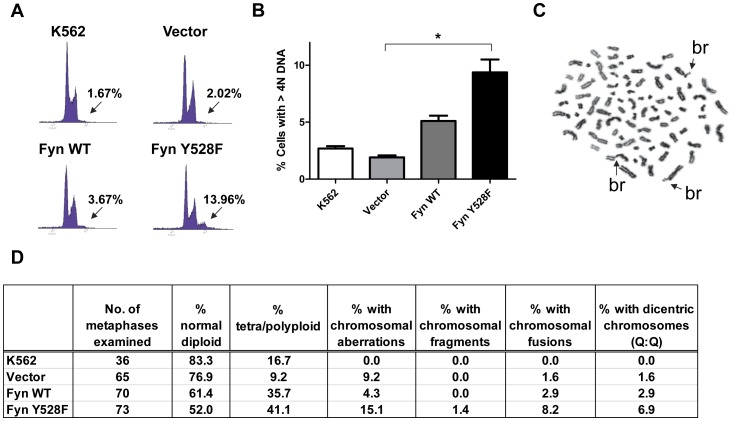
Increased Fyn kinase activity leads to the accumulation of genomic instability in CML cells.(A) Cell cycle profiles of K562 cells transduced with vector, wild-type (Fyn WT), or constitutively active Fyn (Fyn Y528F) were evaluated by propidium iodide staining and analysis by flow cytometry. Histograms are representative of three independent experiments. (B) Graphical representation of the percent of cells with greater than 4N DNA content. *p<0.01, n = 3, mean+SEM. (C) A representative metaphase spread from constitutively active Fyn expressing K562 cells. Chromatid breaks (br) are indicated by arrows. (D) Table depicting the various chromosomal abnormalities seen in Fyn overexpressing K562 cells.